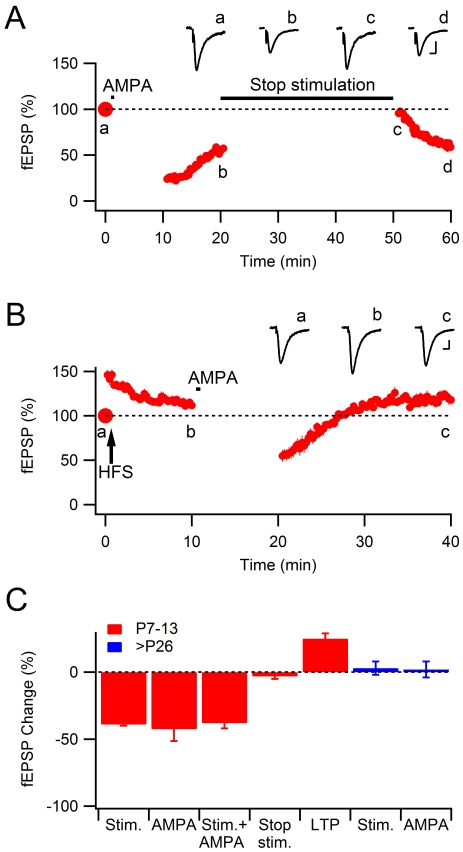
Reversibility and LTP after agonist-induced depression.
A, Summary data for reversibility experiments in which AMPA-induced depression was followed by a pause of stimulation for 30 minutes (n = 6), showing reversal of synaptic signaling to the initial (100%) level. B, Summary data for LTP experiments (n = 6) in which AMPA was applied 10 min after five trains of high-frequency stimulation (HFS, each consisting of 20 stimuli at 50 Hz, 20 s intertrain interval), showing that further agonist-induced depression was prevented. C, Summary of stimulus and agonist-induced depression in extracellular field recordings. All data are means ± s.e.m. Scale bars represent 200 µV and 20 ms. Representative fEPSPs are shown superimposed above the graphs as indicated in the figure.